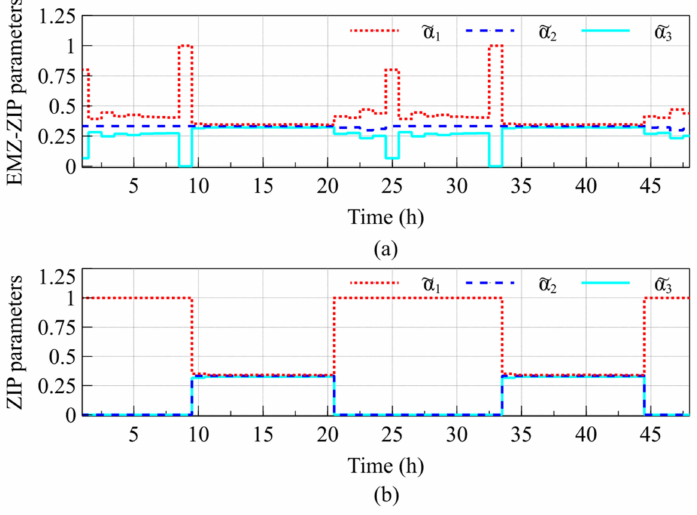
Figure 8. ( a ) Evolution of the parameters (cid:101) α 1, k , (cid:101) α 2, k , (cid:101) α 3, k of the EMZ-ZIP model and ( b ) evolution of the parameters (cid:101) α 1, k , (cid:101) α 2, k , (cid:101) α 3, k of the ZIP